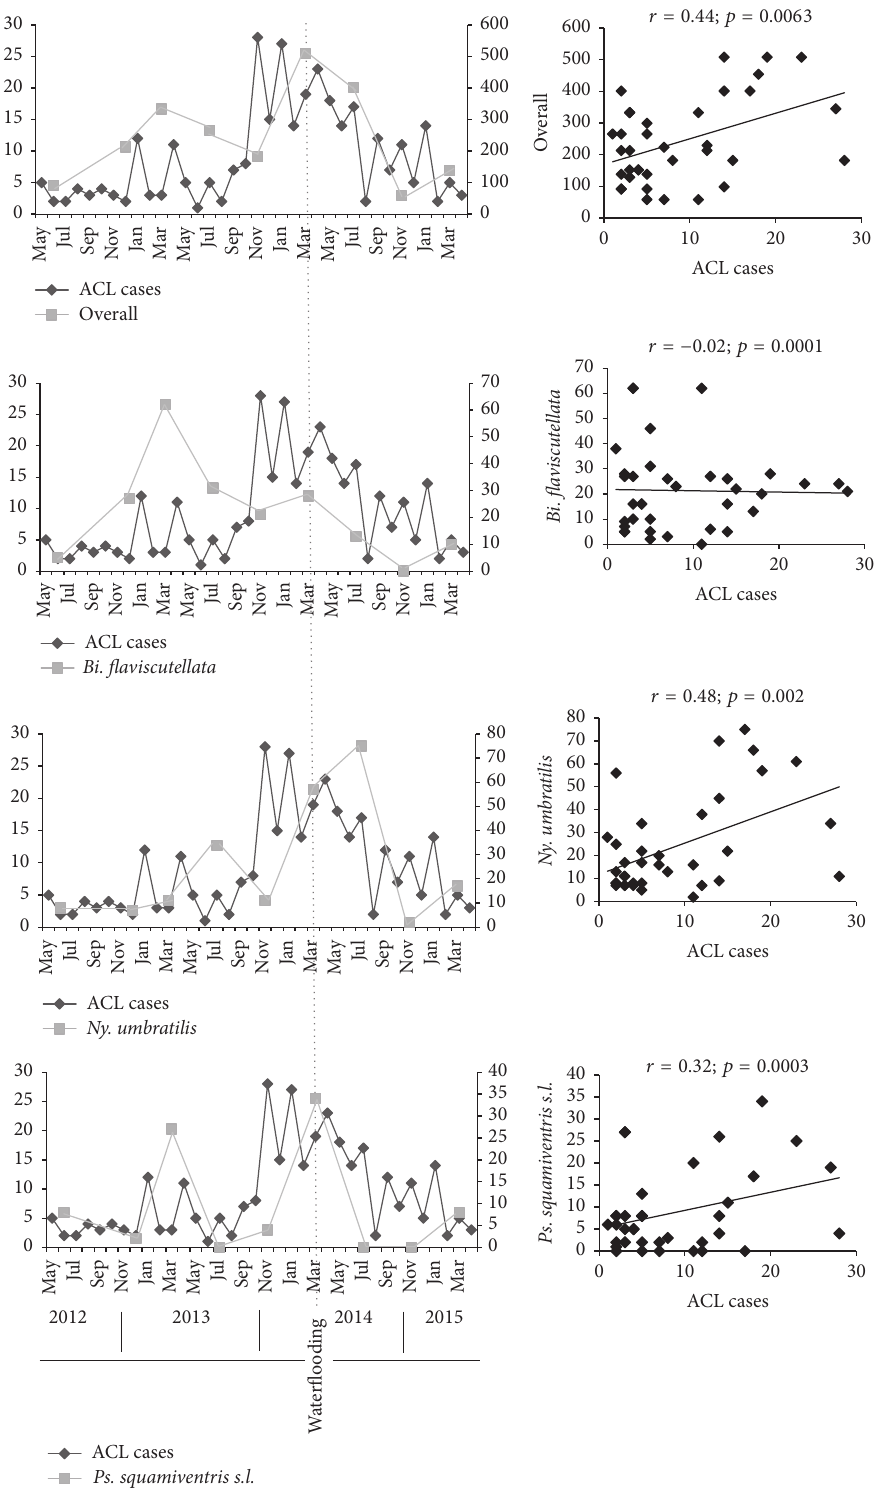
Figure 4: Correlation between ACL cases and phlebotomine putative vector species captured in Santo Antˆonio do Jari hydroelectric system impacted area, between the states of Par´a and Amap´a, Brazil